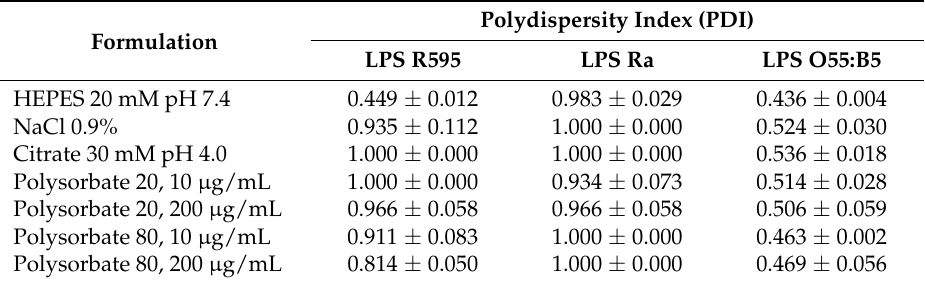
Table 2. Polydispersity index (PDI) for lipopolysaccharides aggregates in different